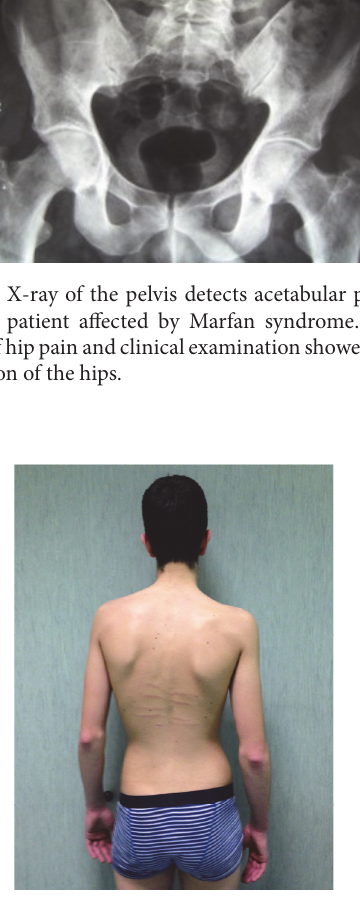
Figure 5: Twenty-five-year-old man affected by Marfan syndrome with scoliosis ( > 20 ∘ ) in addition to dorsal skin striae and reduced elbow extension ( < 170 ∘ ).